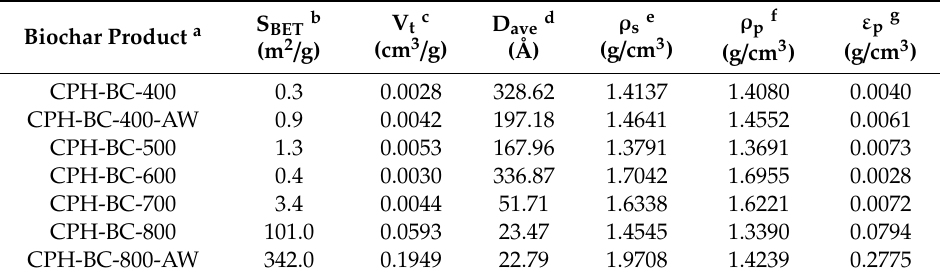
Table 1. Pore properties and densities of CPH-based biochar